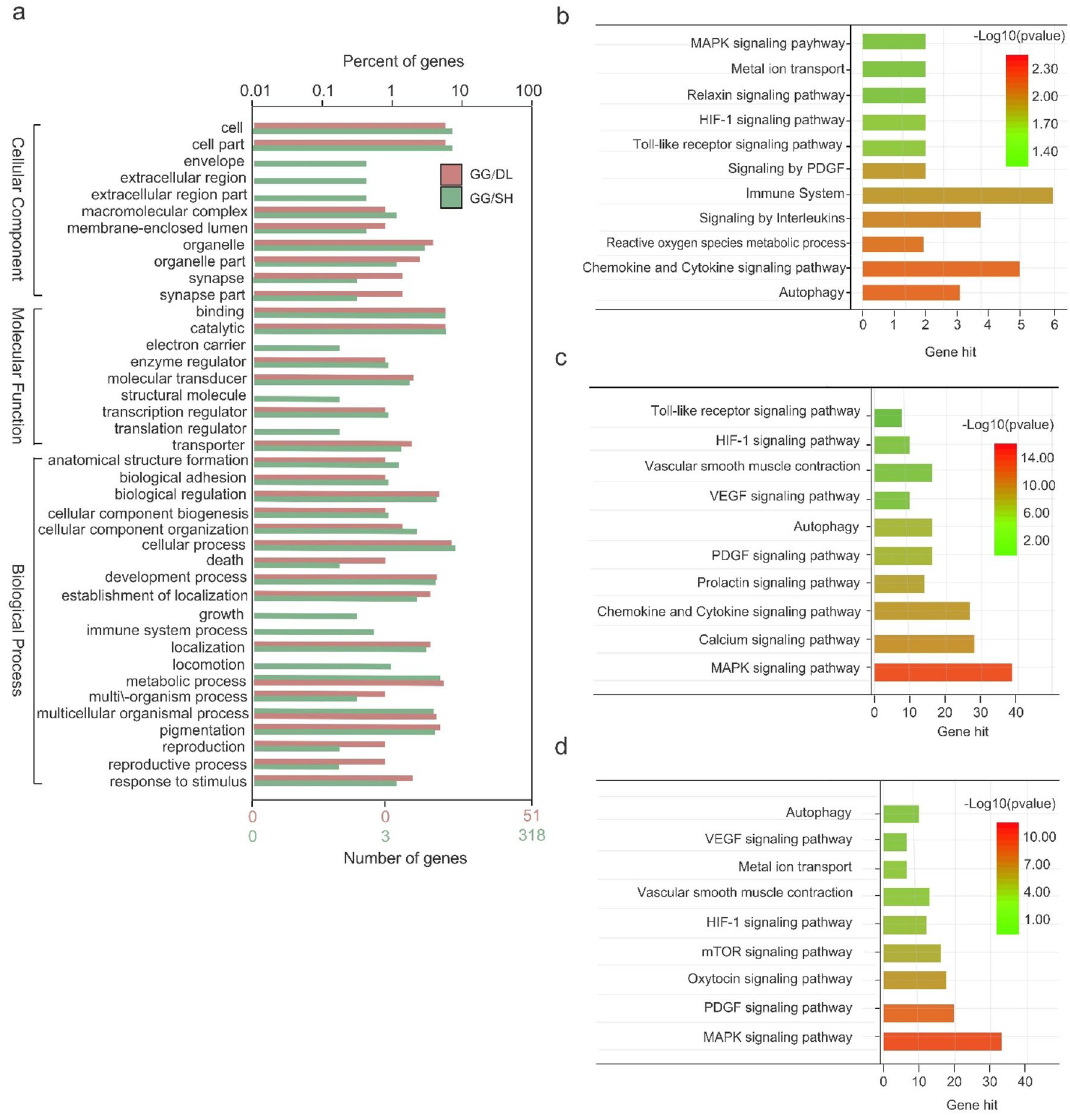
Figure 5. Enrichment analysis of candidate genes. ( a ) GO category analysis of genes using pairwise analysis. ( b ) KEGG category analysis of PSGs in the DL population. ( c ) KEGG category analysis of genes in stop-lost SNPs that are similar to PSGs. ( d ) KEGG category analysis of genes in stop-gained SNPs that are similar to